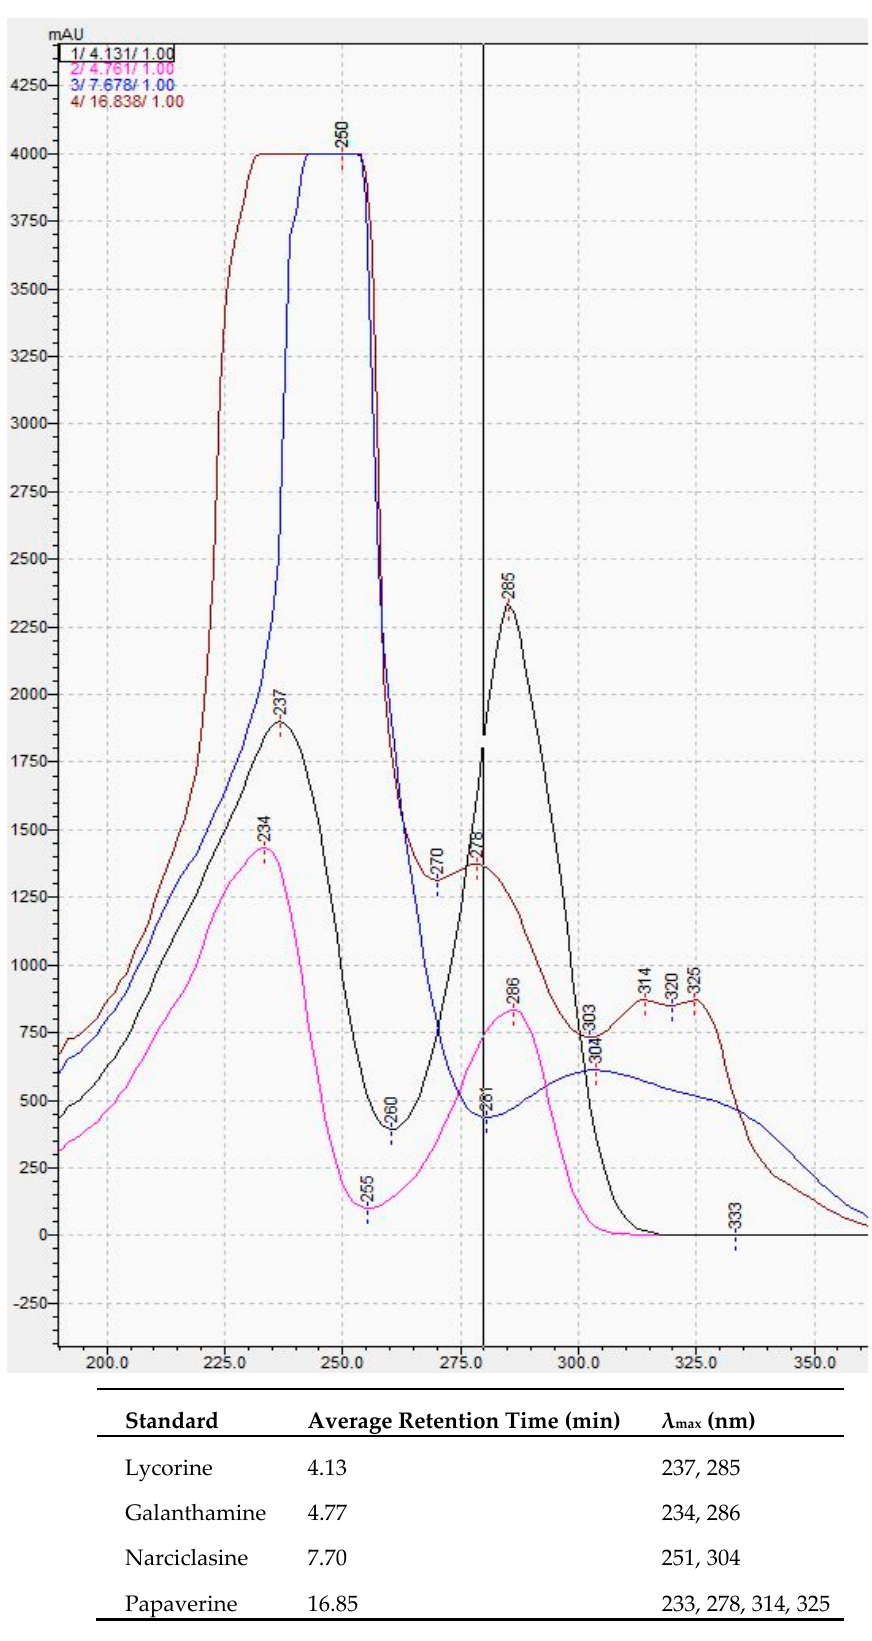
Figure A1. HPLC analysis of alkaloid standards. The chromatogram shows the absorption spectrum of each alkaloid standard. The average retention time and absorption maxima of each alkaloid standard obtained by HPLC-PDA analysis are summarized in the Table A3.